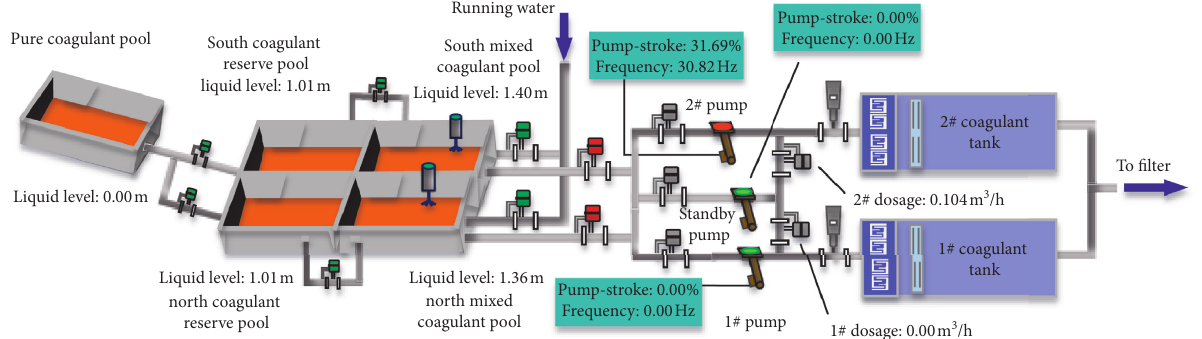
Figure 5: The diagram of the dosage system. Table 1: Dimension reduction for NNM by PCA (40